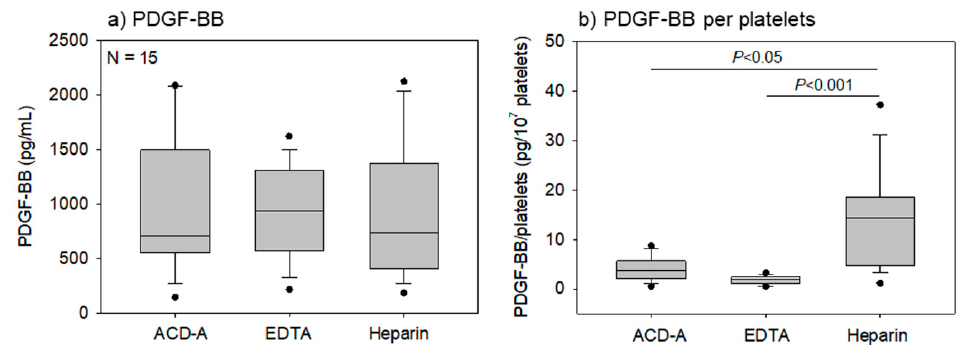
Figure 7. Effects of anticoagulants on Platelet-derived growth factor-BB (PDGF-BB) concentration in pure-PRP samples. Pure-PRP samples were prepared from whole-blood samples stored for 24 h and stored at − 80 °C until ELISA. ( a ) PDGF-BB concentration and ( b ) PDGF-BB levels in 10 7 platelets. n = 15.